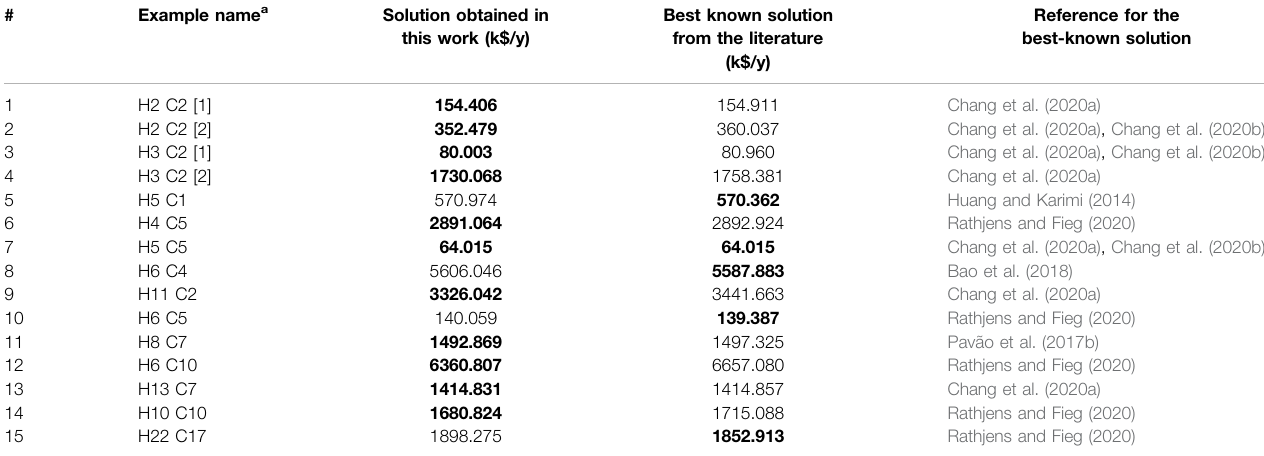
a The digits after the “ H ” and “ C ” indicate the number of hot and cold process streams respectively. In bold appears the best known solution after this work.